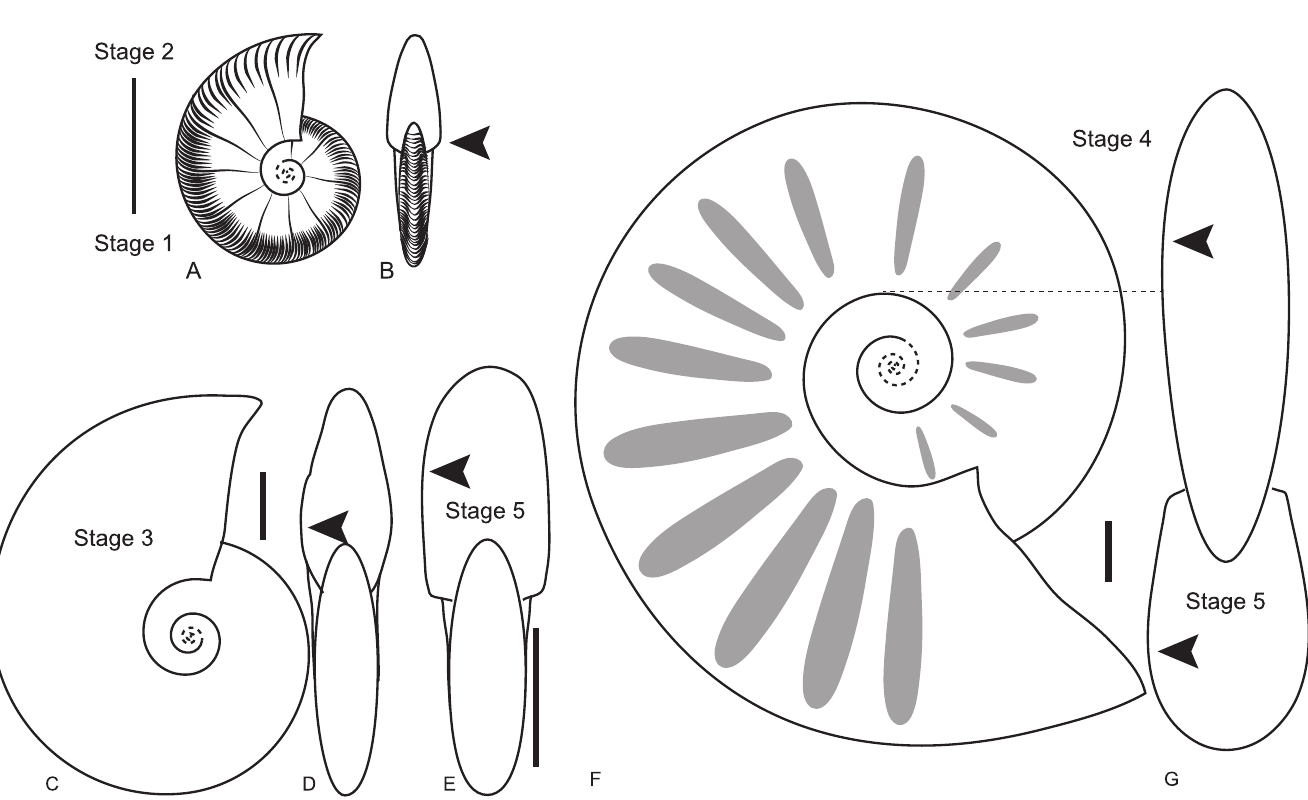
Fig 4. Ontogenetic stages of Parapuzosia ( P .) seppenradensis from the Jime´nez area of Coahuila, north-eastern Mexico. A–B: juvenile stage 1, drawn from CPC– 2204 from bed TPY 77. C–D: juvenile stage 3 (inner) and 4 (outer whorl), drawn from CPC–2206, macroconch from bed TPY 57 in lateral (C) and apertural view (D). E: juvenile stages 3–4 (inner) and 5 (outer whorl), drawn from CPC–2201, microconch from bed TPY57. Note that stage 5 is reached at a rather small diameter. F-G: macroconch juvenile stage 4, subadult stage 5 in the last quarter whorl, drawn from CPC–1000, precise origin within the Jime´nez area is unknown. Drawings by CI. Scale bar = 100